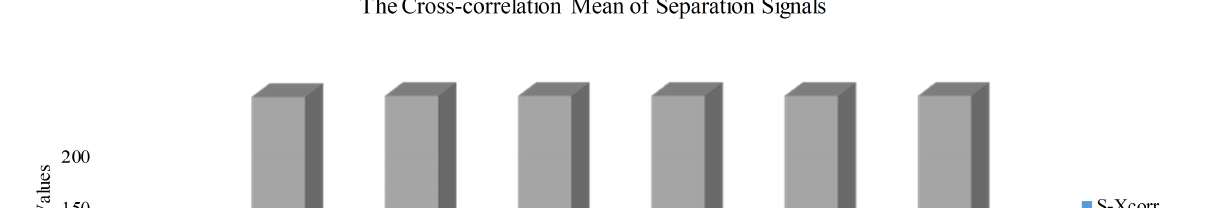
Sensors 2022 , 21 , x FOR PEER REVIEW 10 of 16 The mean values of cross-correlations of the source signals and the separated signals by SI-BSS and SI-XBSS are shown in Figure 9. The results showed that the source signals had the lowest cross correlation value—less than 20; the value by SI-XBSS was very close to that of the source signals with a range from 55.20 to 58.70; and the separated signals by the SI-BSS was from 180.98 to 182.00, which was more than four times of that of the source signals. It could be inferred that the smaller the cross-correlation value between signals was, the lower the similarity of the signals was. For the separated signals, the cross-corre- lation value can reflect the difference of separated signals, which means the lower the value of cross-correlation was, the better the separation performance was.